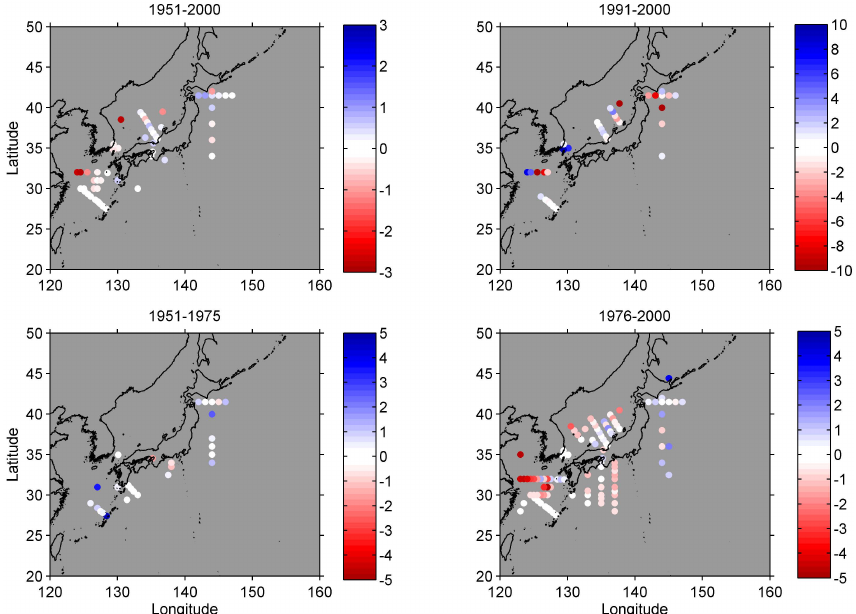
Fig. 7. Oxygen concentration trends (µmolL − 1 yr − 1 ) computed from a global oxygen database at 20m depth around Japan for (a) 1951–